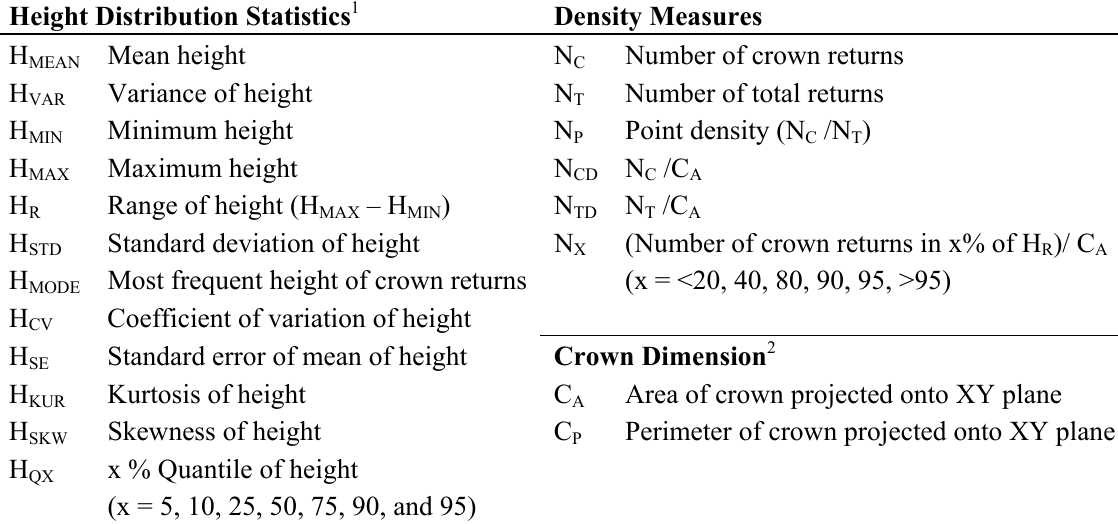
Table 2. Candidate predictor variables computed using normalized point clouds from individual